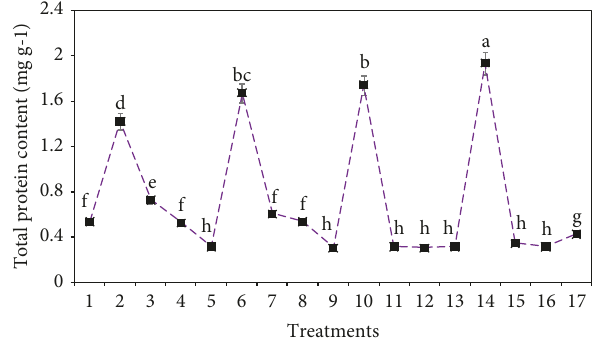
Figure 12: Impact of biosorbed water by various biosorbents (orange peels, pomegranate peels, and peanut peels) on total protein content of mung bean after 7 days of seed germination. T1, negative control; T2, 50 mg kg − 1 ; T3, pomegranate peel biosorbed